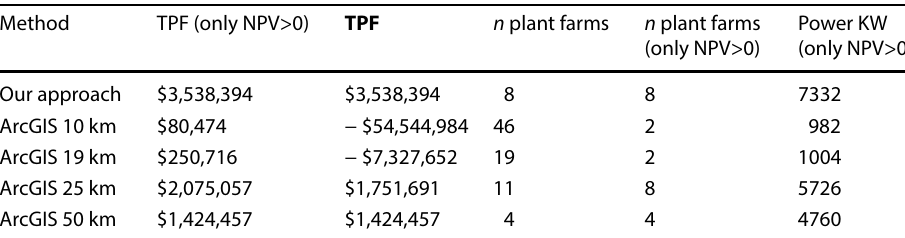
Fig. 3 Plant locations accord- ing to our algorithm, in the most profitable